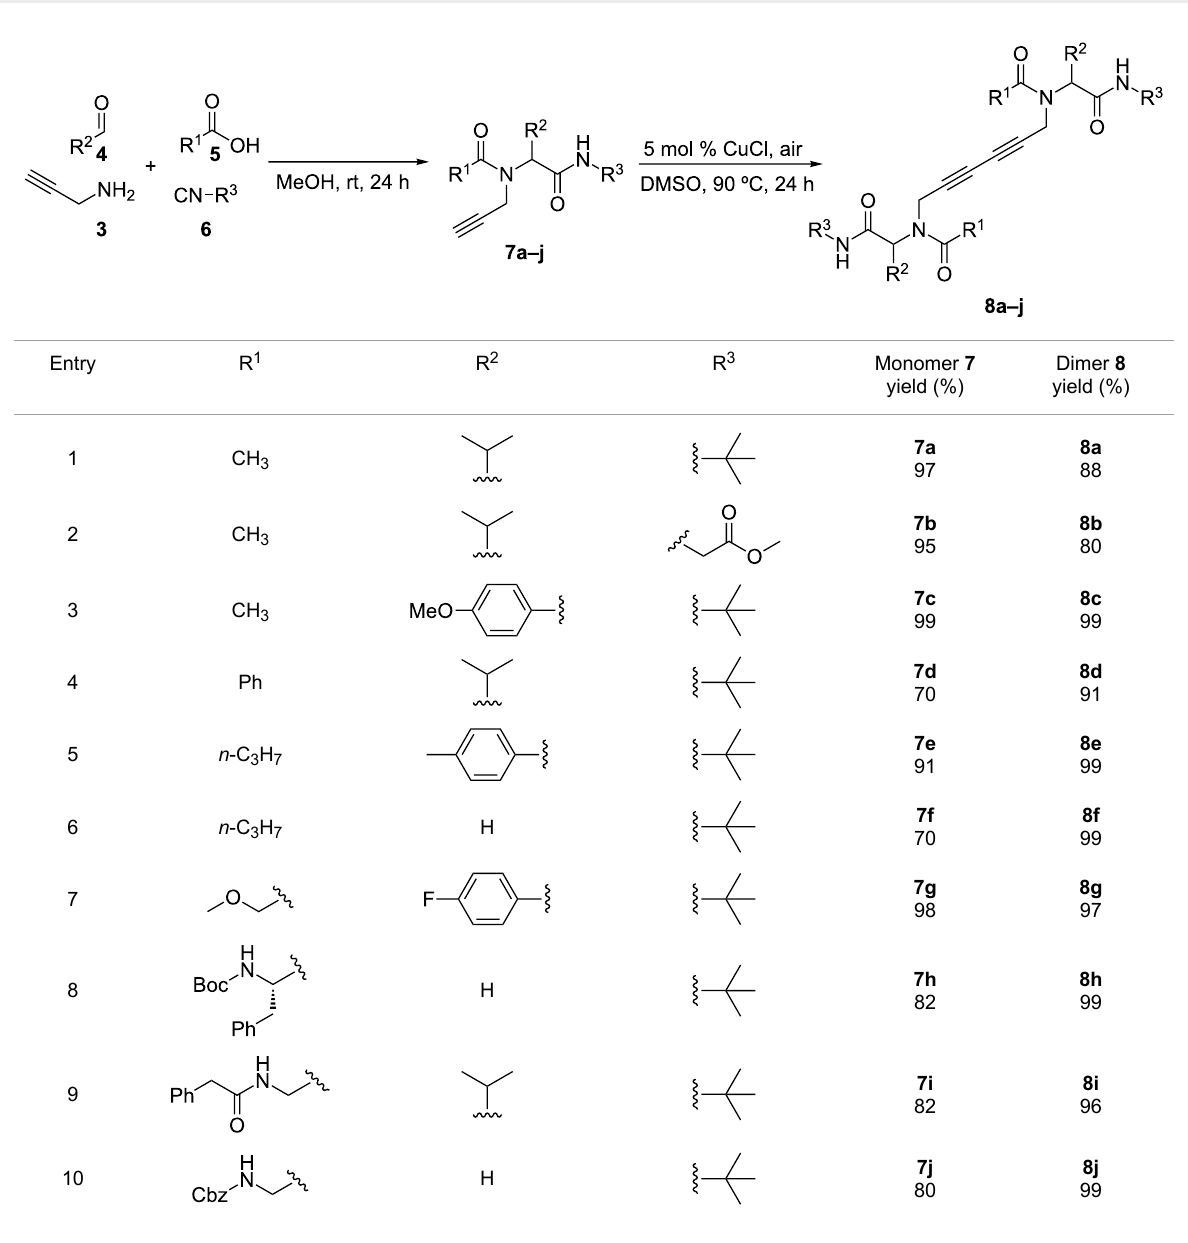
Table 1: Synthesis of compounds 7a–j and 8a–j